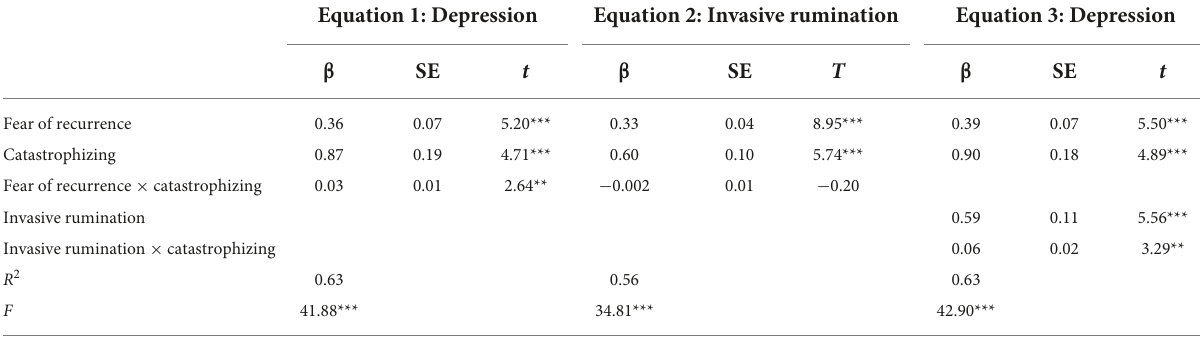
TABLE 6 Moderating role of catastrophizing emotion regulation strategy on fear of recurrence, invasive rumination, and depression. Equation 1: Depression